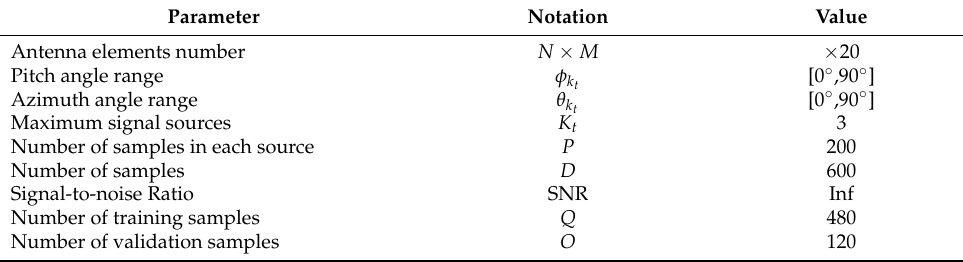
Table 2. Simulation parameters of 2D DOA